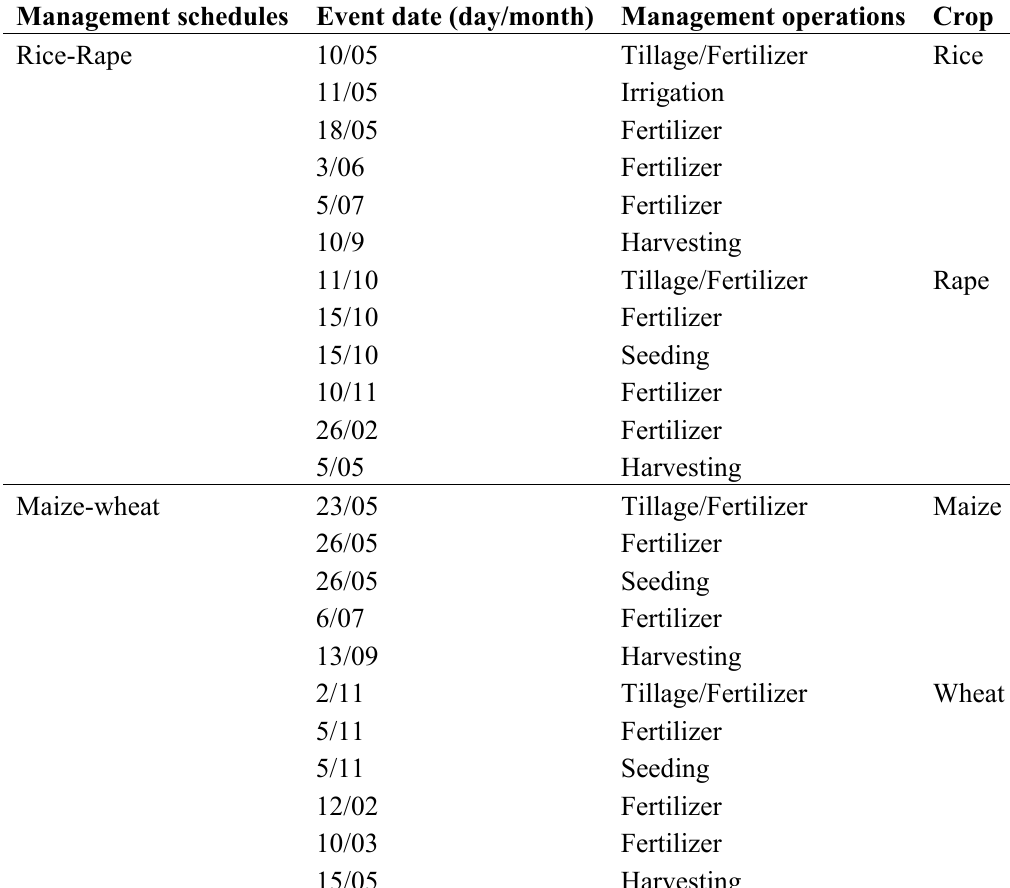
Table 6. Major crops grown, management schedules and management operations identified in the